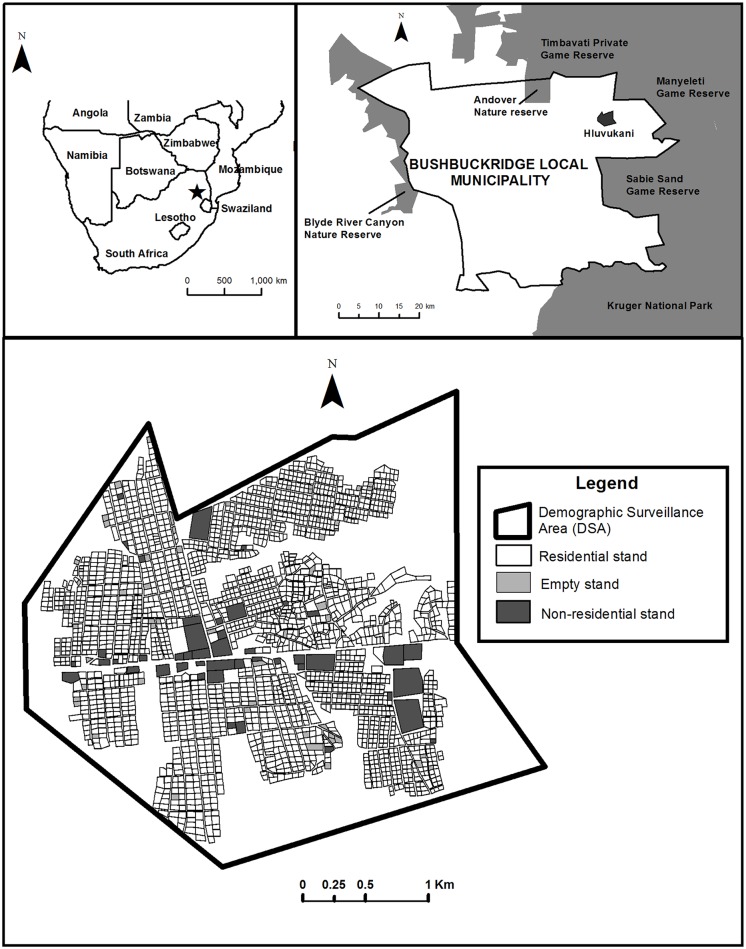
Location of the owned dog demographic surveillance area (DSA) in Hluvukani, South Africa, and of all stands within the DSA.